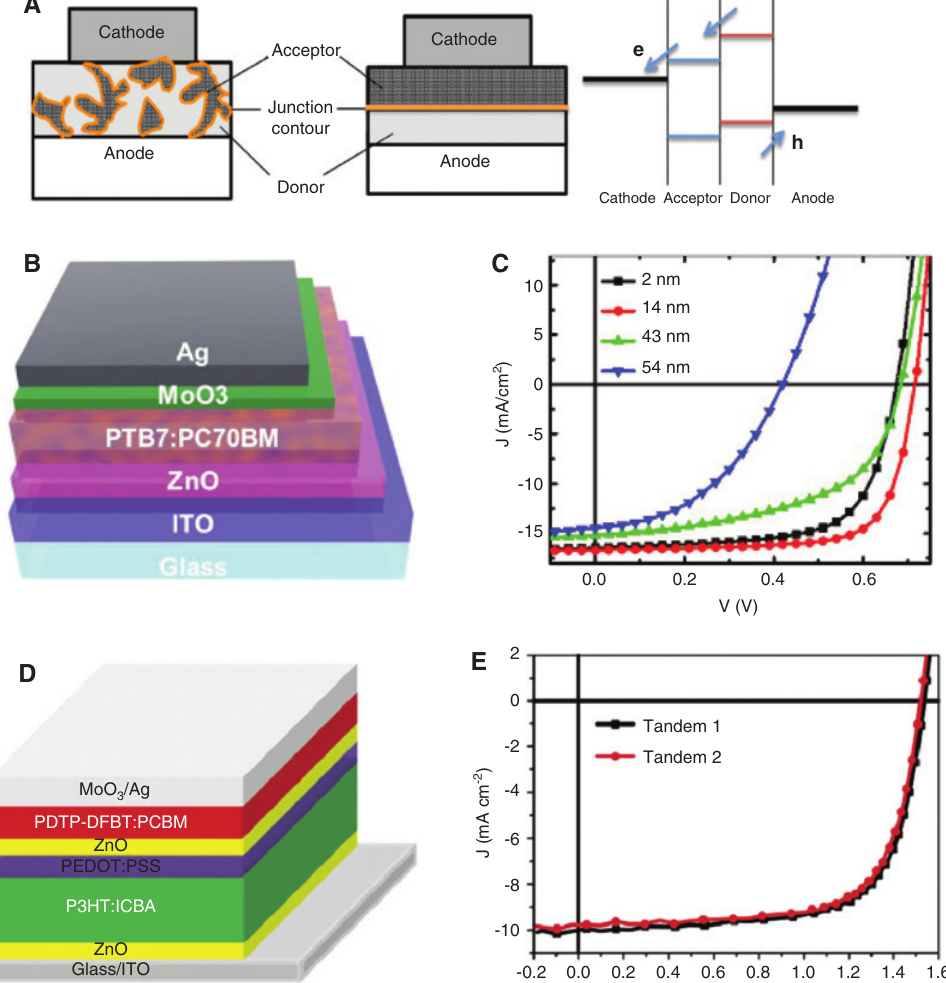
Figure 4: (A) BHJ structure (left), FPJ structure (middle), and typical band interfaces (right) of an OPV device. (B) Device schematic and (C) J-V curves at different ZnO layer thickness of the structure in (B) [12]. (D) Device structure and (E) measured J-V curves of the highest recorded efficiency of tandem organic solar cell